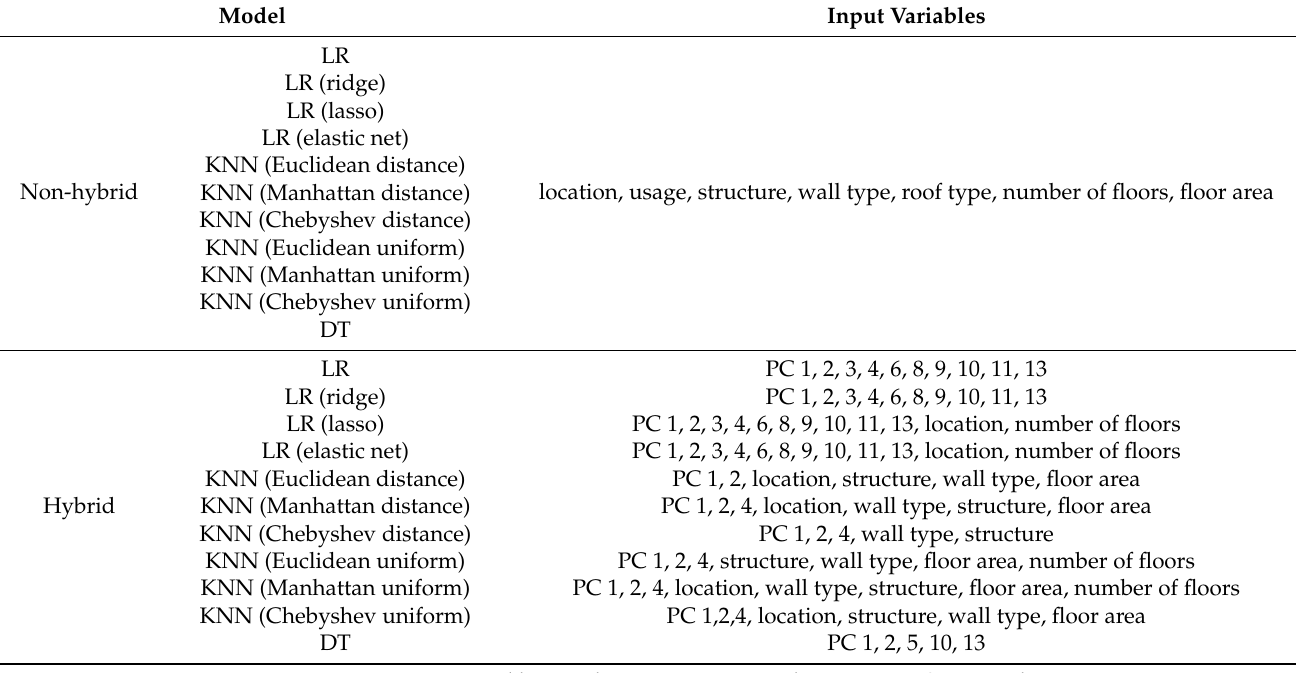
Table 4. Input variables used to develop the non-hybrid and hybrid machine-learning predictive